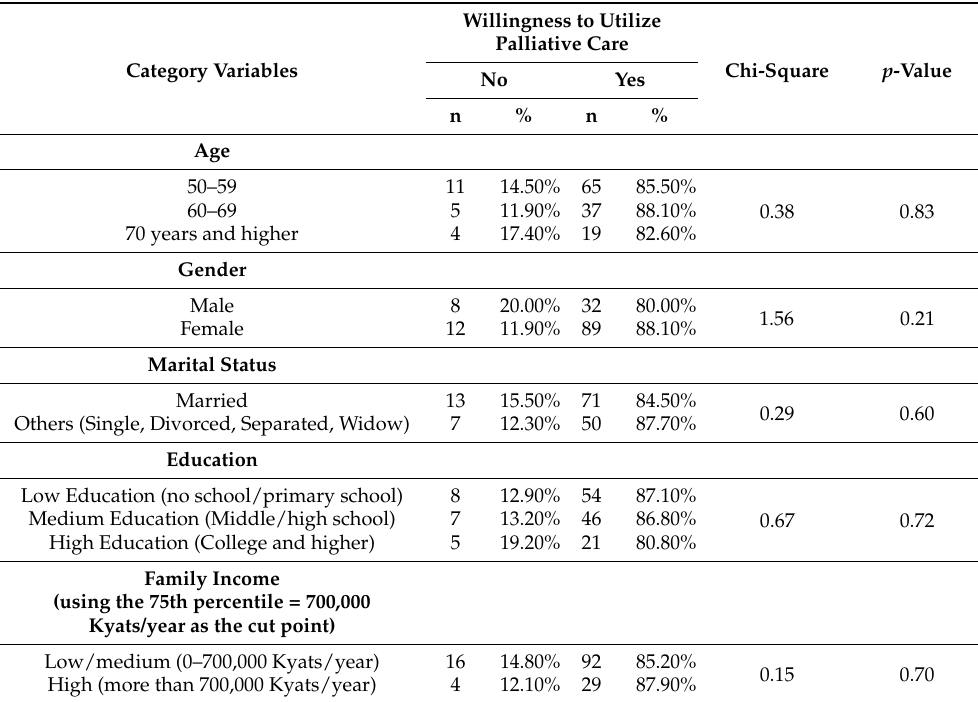
Table 4. Association between categorized independent variables and willingness to utilize palliative